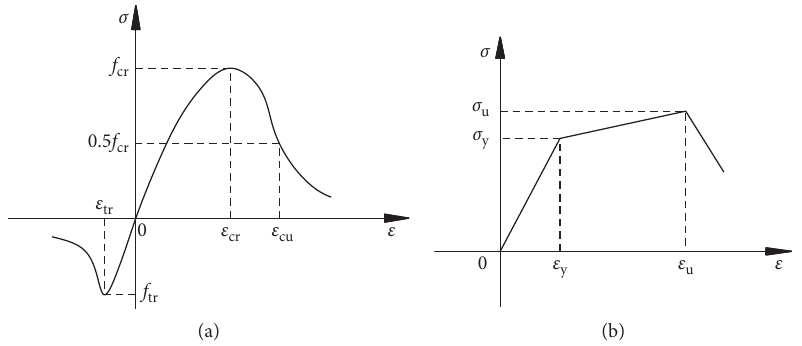
Figure 14: Stress-strain relationship of materials: (a) concrete; (b) steel reinforcement.